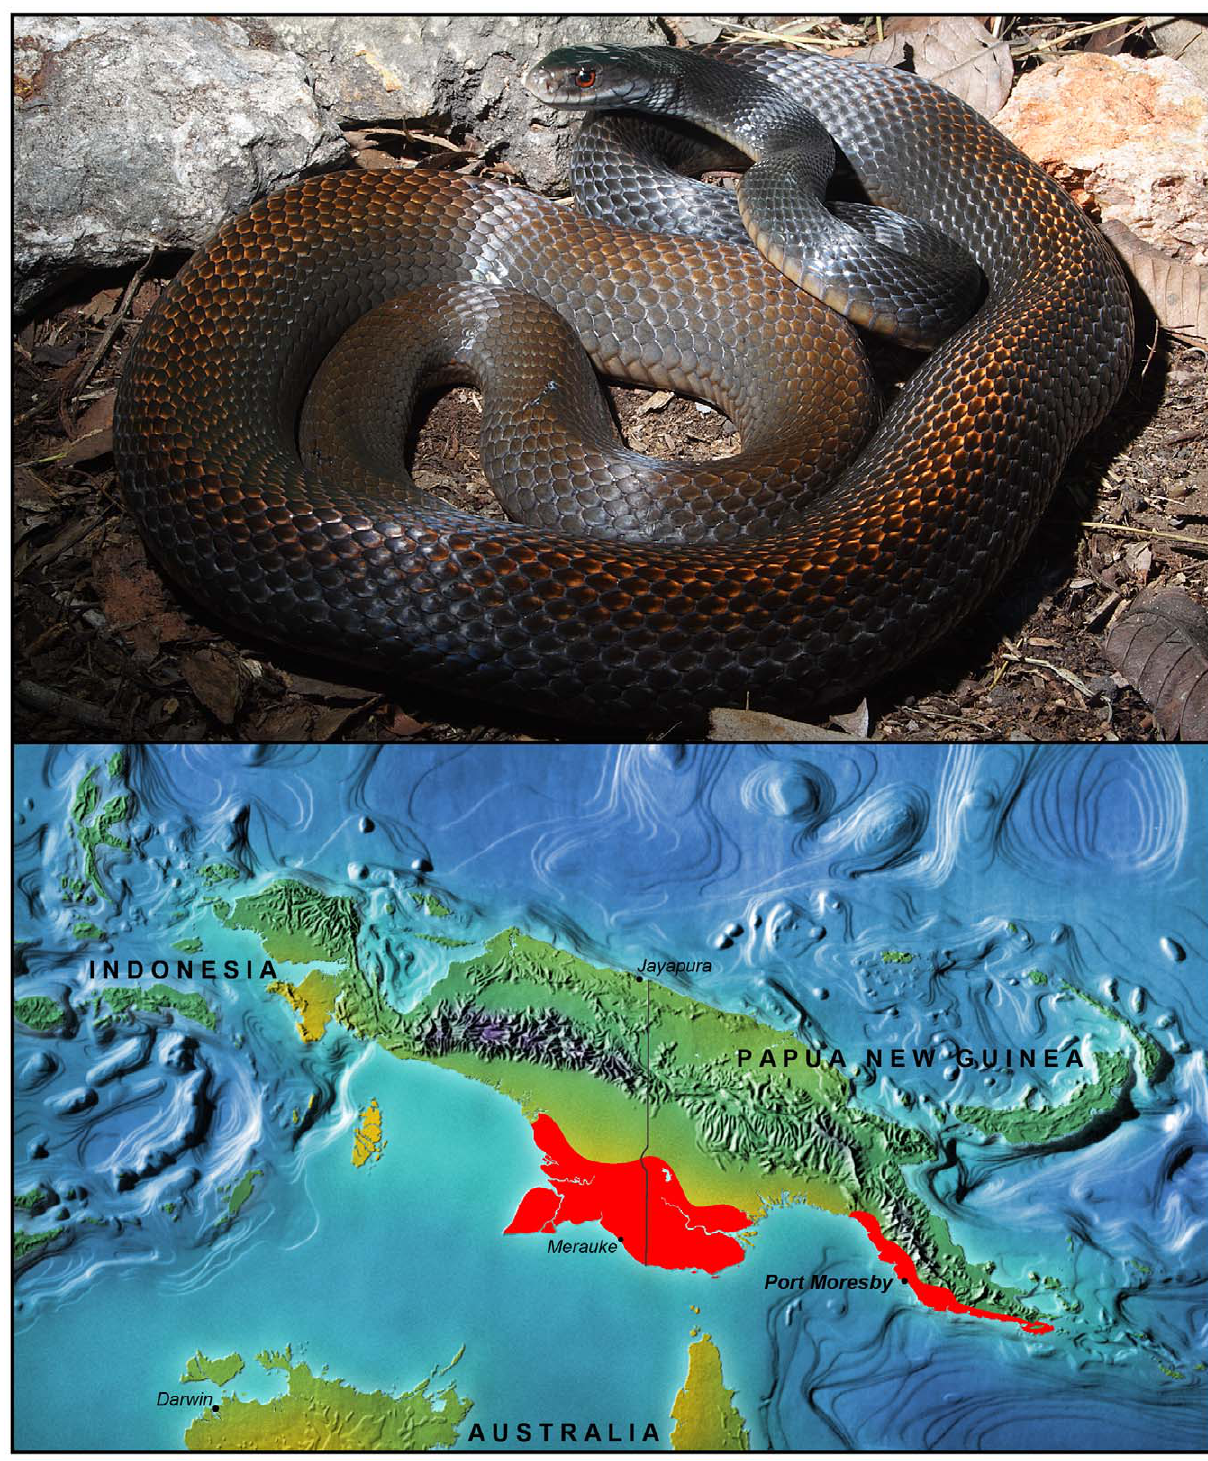
Figure 1. Oxyuranusscutellatus from Papua New Guinea. Adult specimen from Padi Padi, Milne Bay Province, Papua New Guinea, and distribution map showing the range of this species in PNG and Indonesia’s Papua Province (Photo and artwork: DJ Williams). When a satisfactory neutralising titre was reached, the animals were bled from the jugular vein, with the blood being collected in 6 L plastic bags containing sodium citrate as anticoagulant. After sedimentation of blood cells, the plasma was separated and the